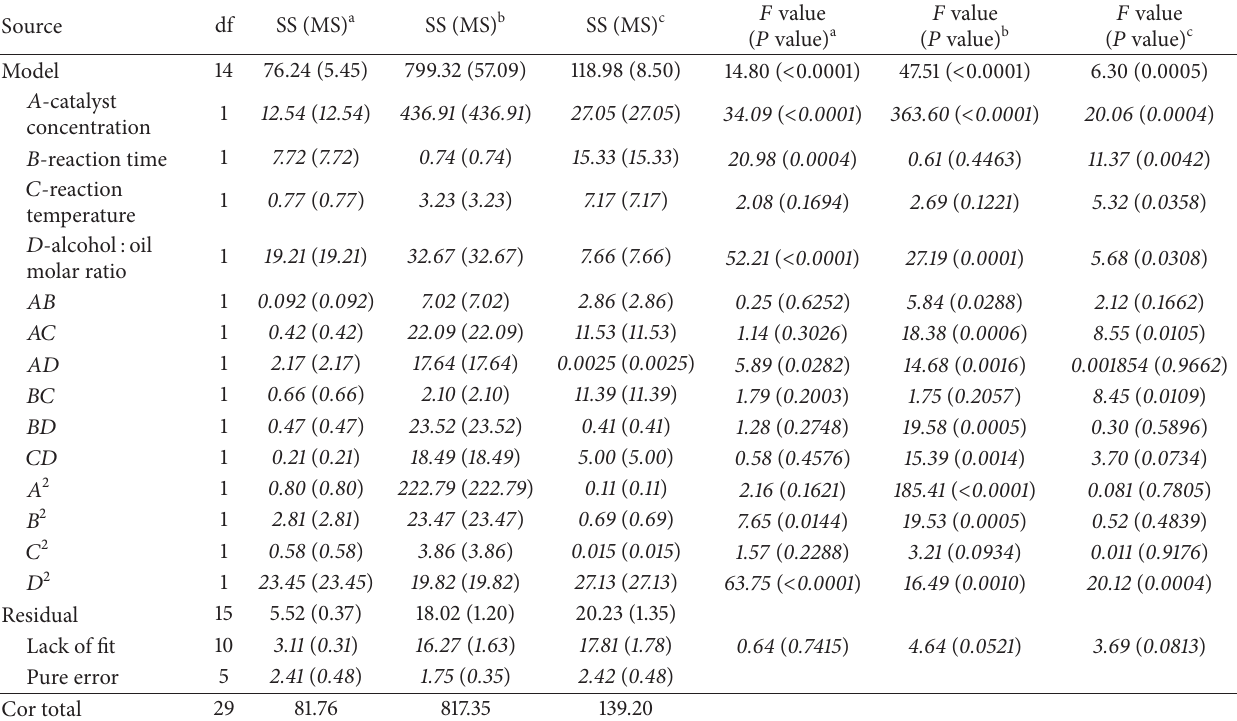
Table 3: Response surface quadratic model analysis of variance (ANOVA) table for chemical transesterification of palm oil.